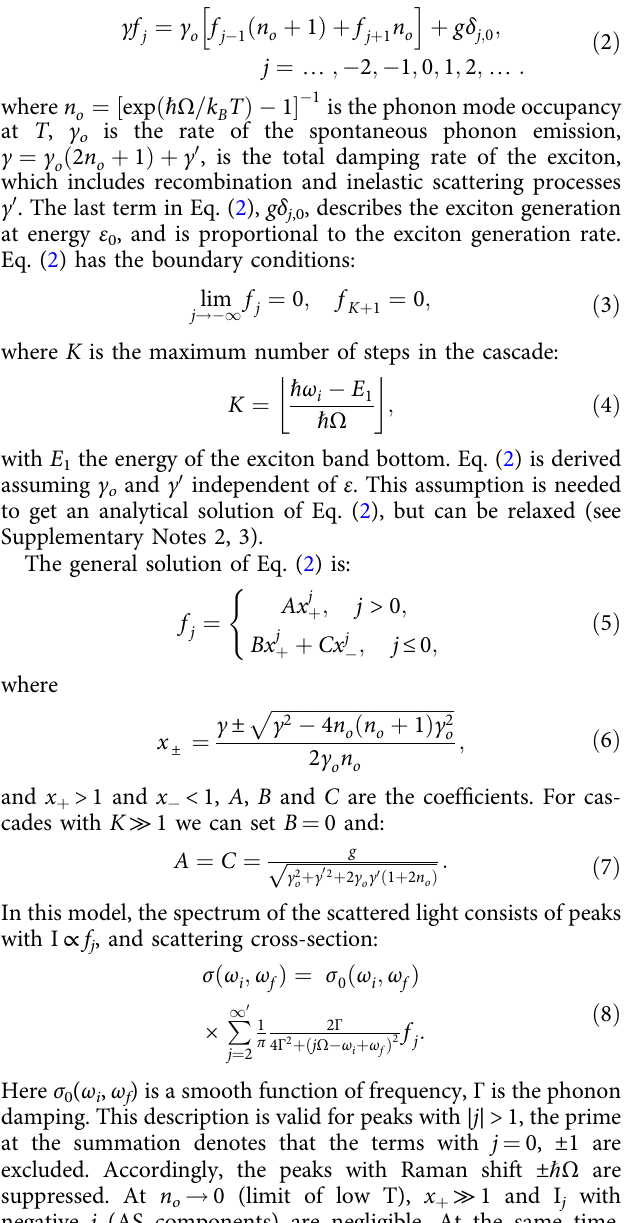
Fig. 3d. The conduction band minima in these valleys are rela- formation and relaxation 62 – 65 . In this case, h remain in K (or K 0